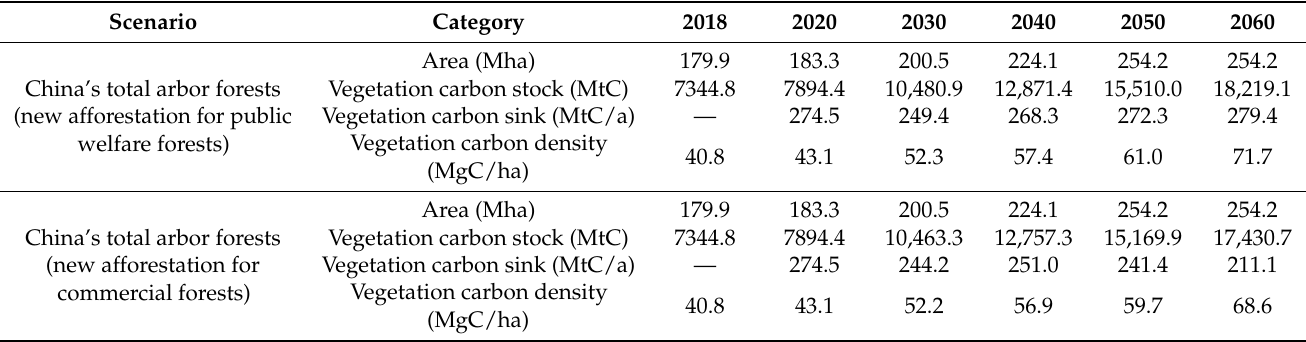
Table 5. Vegetation carbon sink by total arbor forests in China.